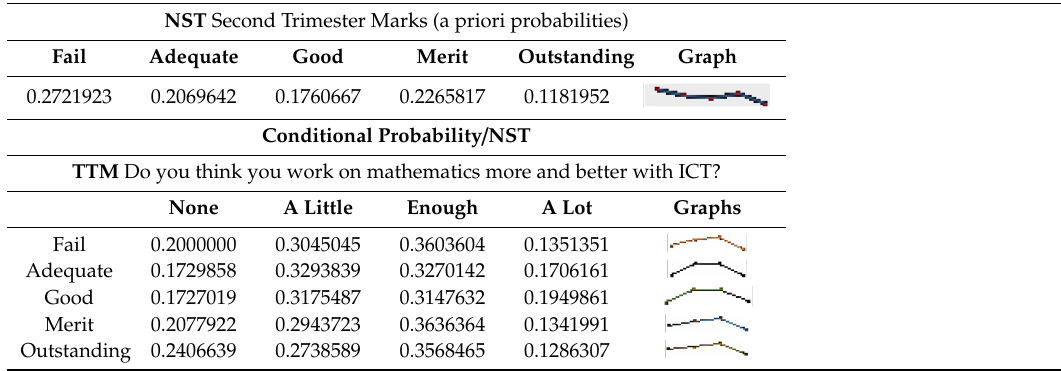
Table 2. A priori probabilities of second trimester marks (NST) and conditional probabilities /